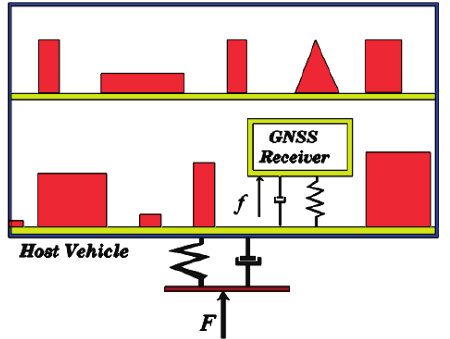
Figure 1. GNSS receiver installed in a highly dynamic host vehicle.